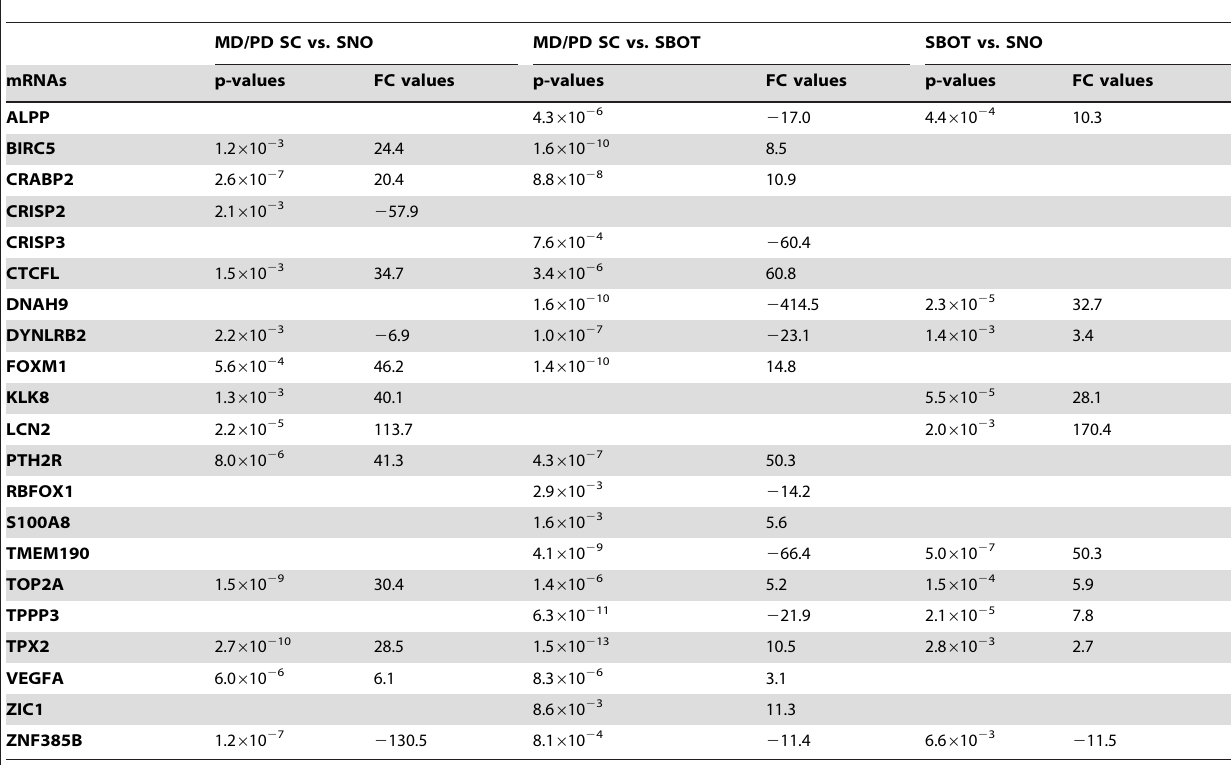
- illustrate downregulation. FC: Fold change. Further abbreviations are given in Table 1and 3. doi:10.1371/journal.pone.0046317.t004 PLOS ONE |